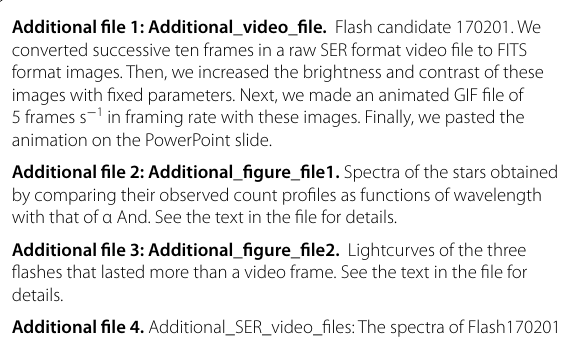
a The solar longitudes at the time of detections in degree b The angle measured from local horizons in